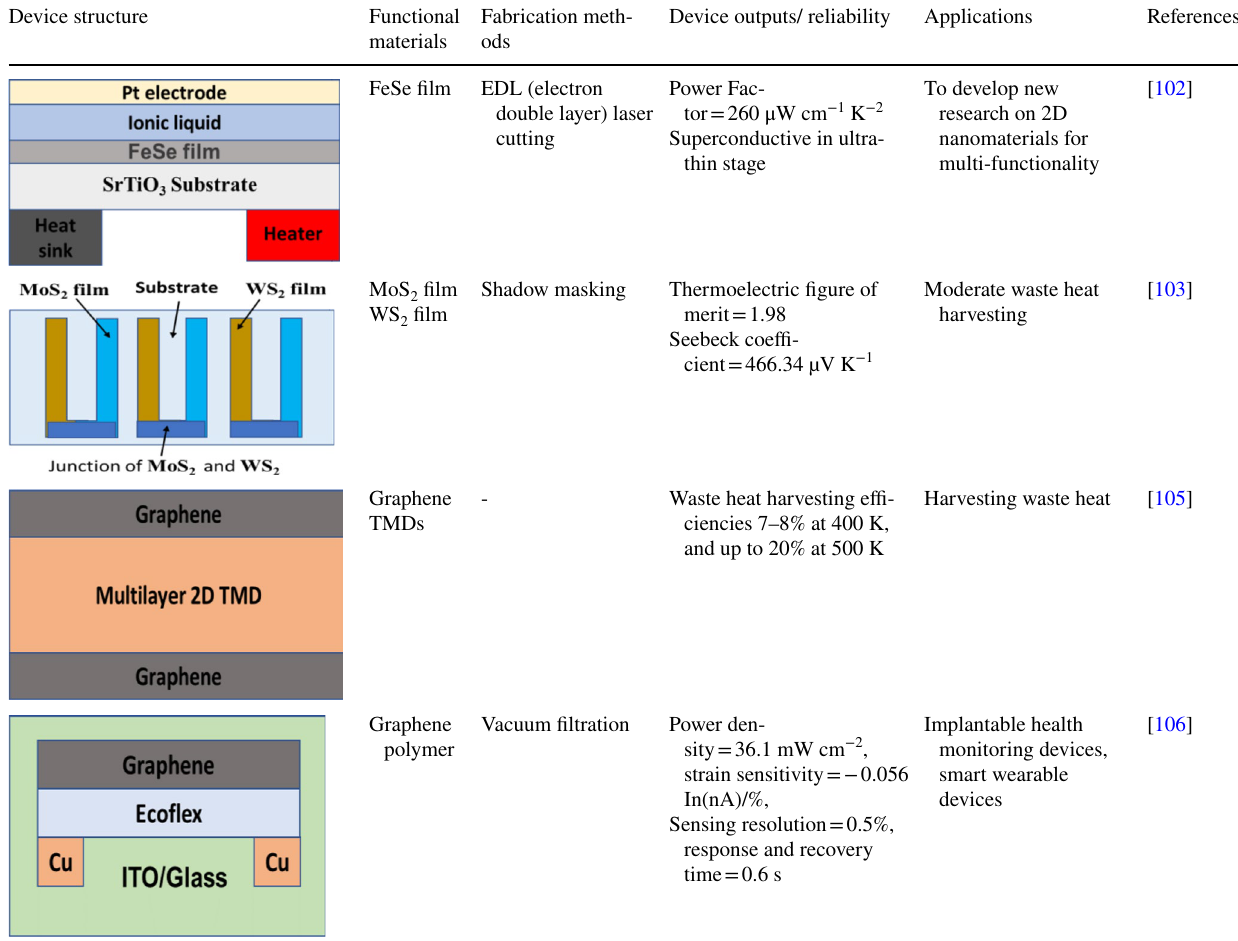
Table 4 Comparative summary of reported work on thermoelectric energy scavenging including device structure, functional materials, fabrica- tion techniques, and device outputs Device